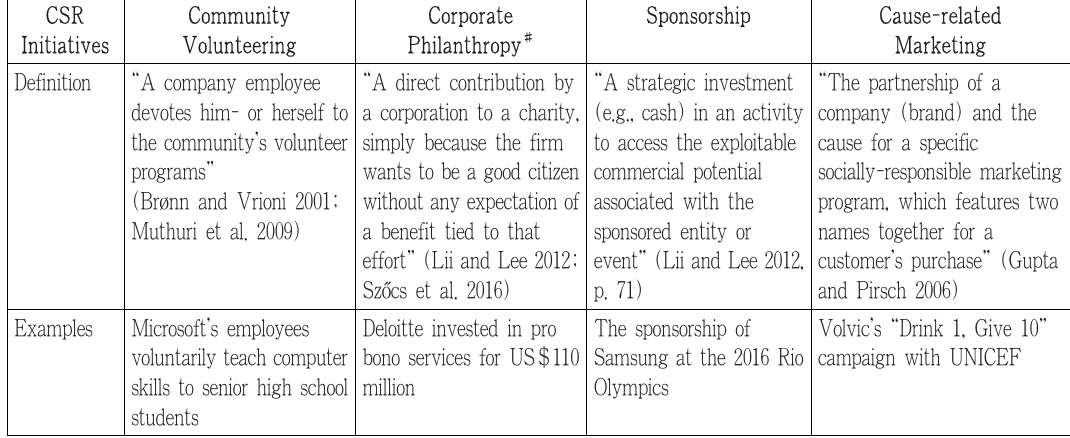
<Table 1> Defitions and Examples of Four Major CSR